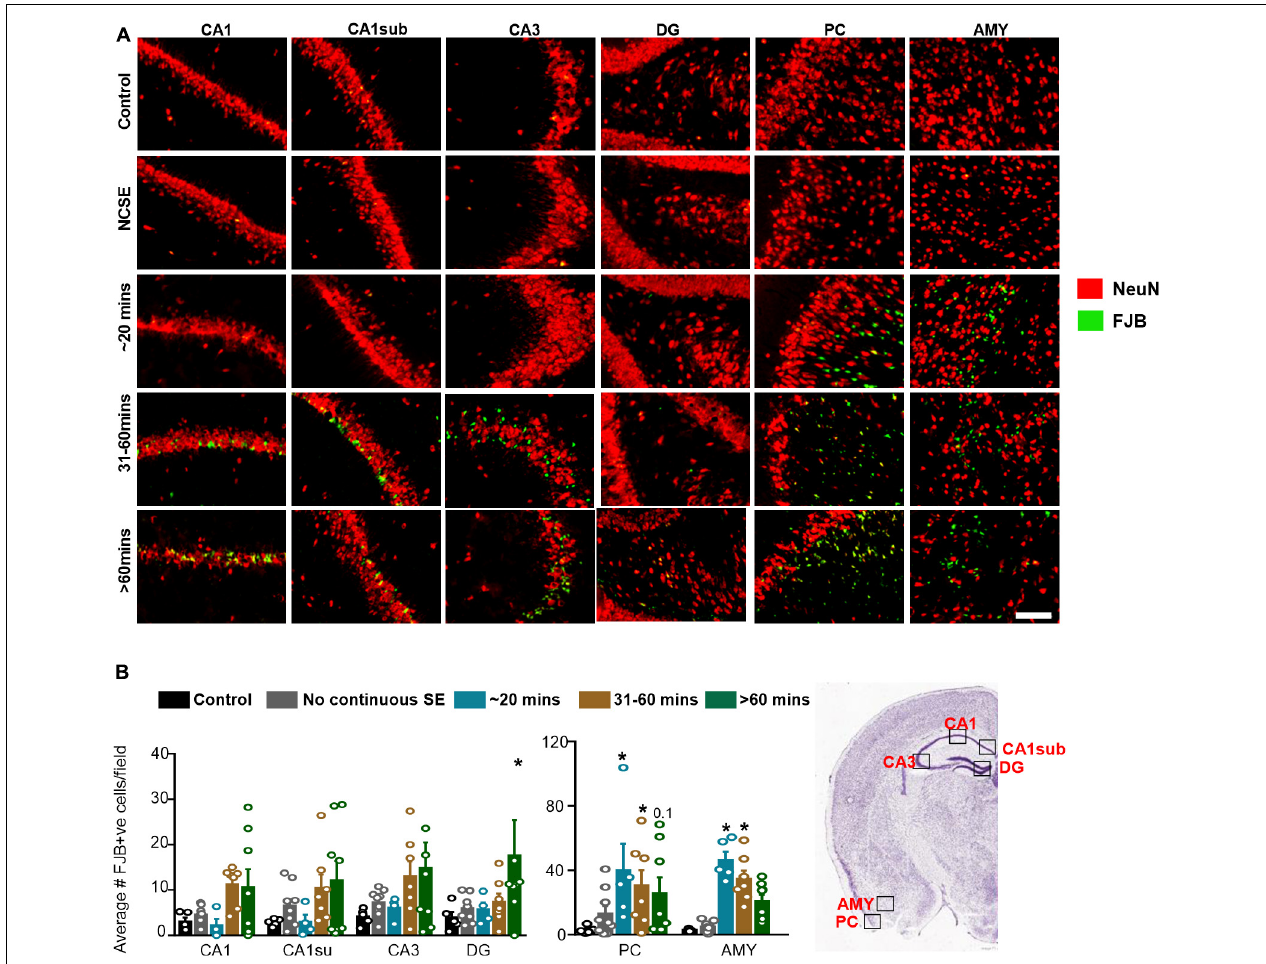
FIGURE 7 | Impact of SE severity and duration on neurodegeneration. (A) Representative images of the hippocampus (CA1, CA1 close to the subiculum = CA1sub, CA3, DG), piriform cortex (PC) and amygdala (AMY). (B) Average number of FJB positive cells (mixed effects ANOVA, n = 5-9). Error bars indicate standard error of the mean. * p < 0.05 compared to control. Field = 0.14 mm 2 . Atlas Image credit: Allen Institute, United